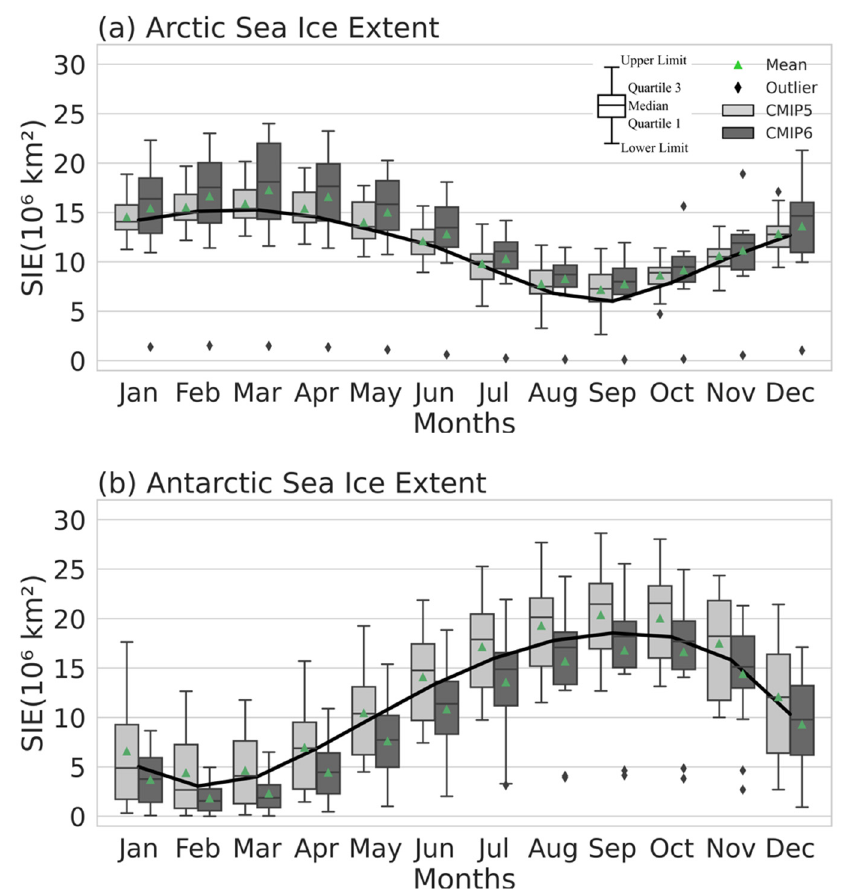
Figure 1. ( a ) Arctic and ( b ) Antarctic SIE seasonal cycle as simulated by CMIP5 (light gray rectangle) and CMIP6 (dark gray rectangle), respectively related to the period 1980–2005 and 1980–2014. Satellite observations for the respective months are represented by the black lines. The boxplots indicate the central 50% intermodal range (25–75%), the median and the upper and lower limit in CMIP5 and CMIP6 under historical experiment. The green triangle shows the average value of the set of models. The black diamond represents the outline values.